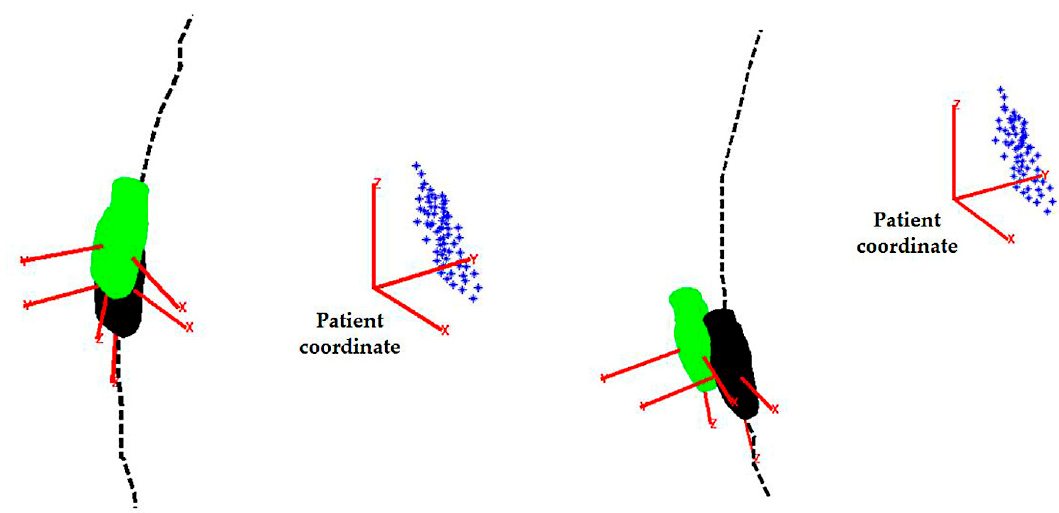
Figure 7. Examples of the pre-planned probe locations (probe head in black) and the real obtained probe locations (probe head in green) from the experiment with the pre-defined targets to be monitored (markers in blue) shown. The probe tip and the patient coordinates are shown in red.